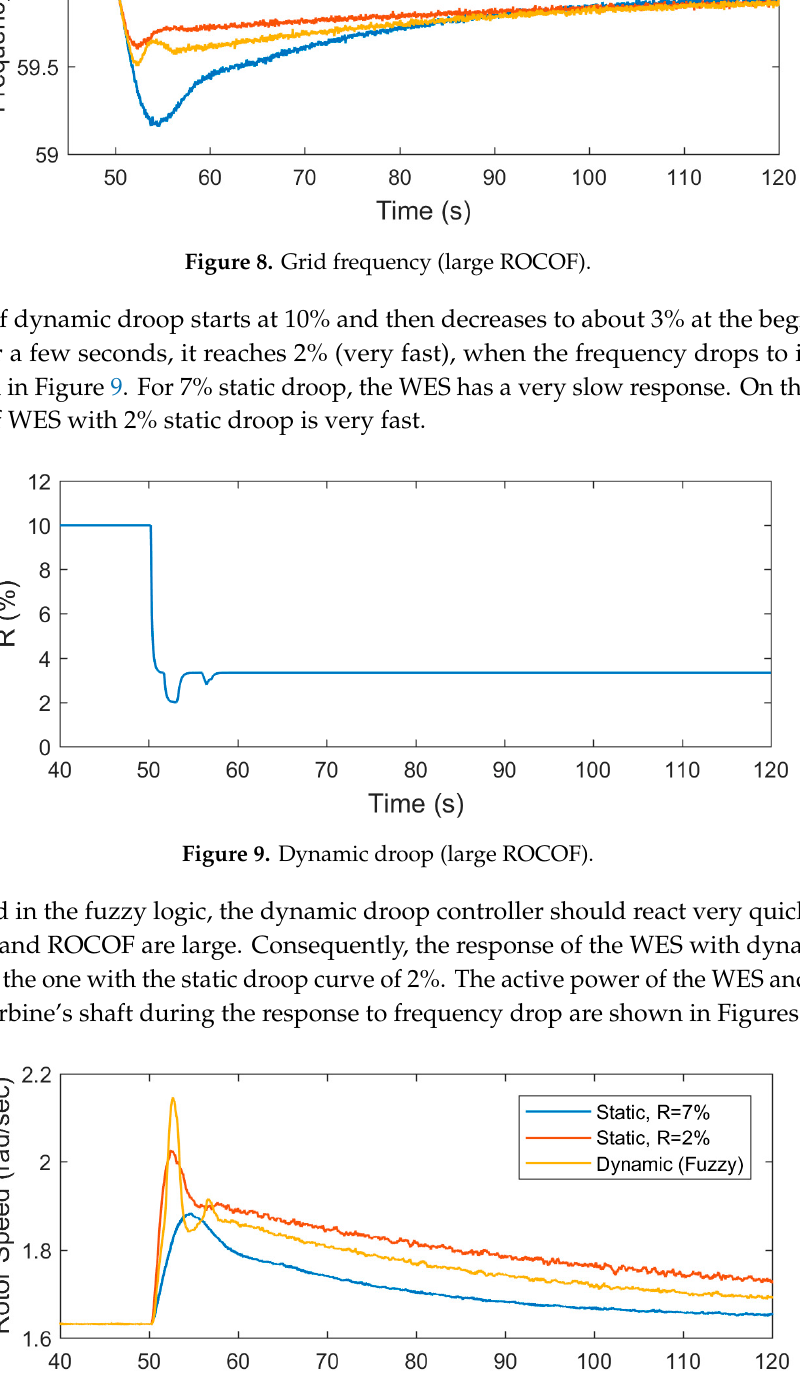
Figure 7. Grid frequency of the event without wind turbine participation.